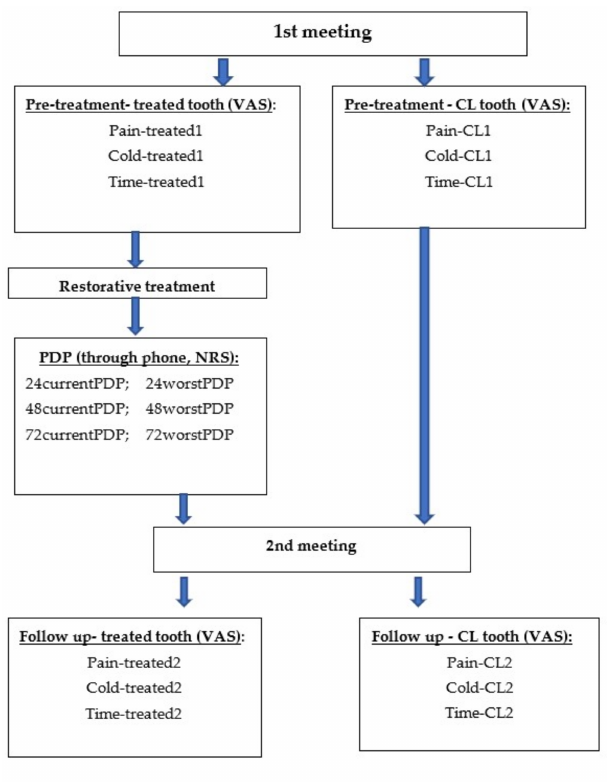
Figure 1. Flowchart of the study